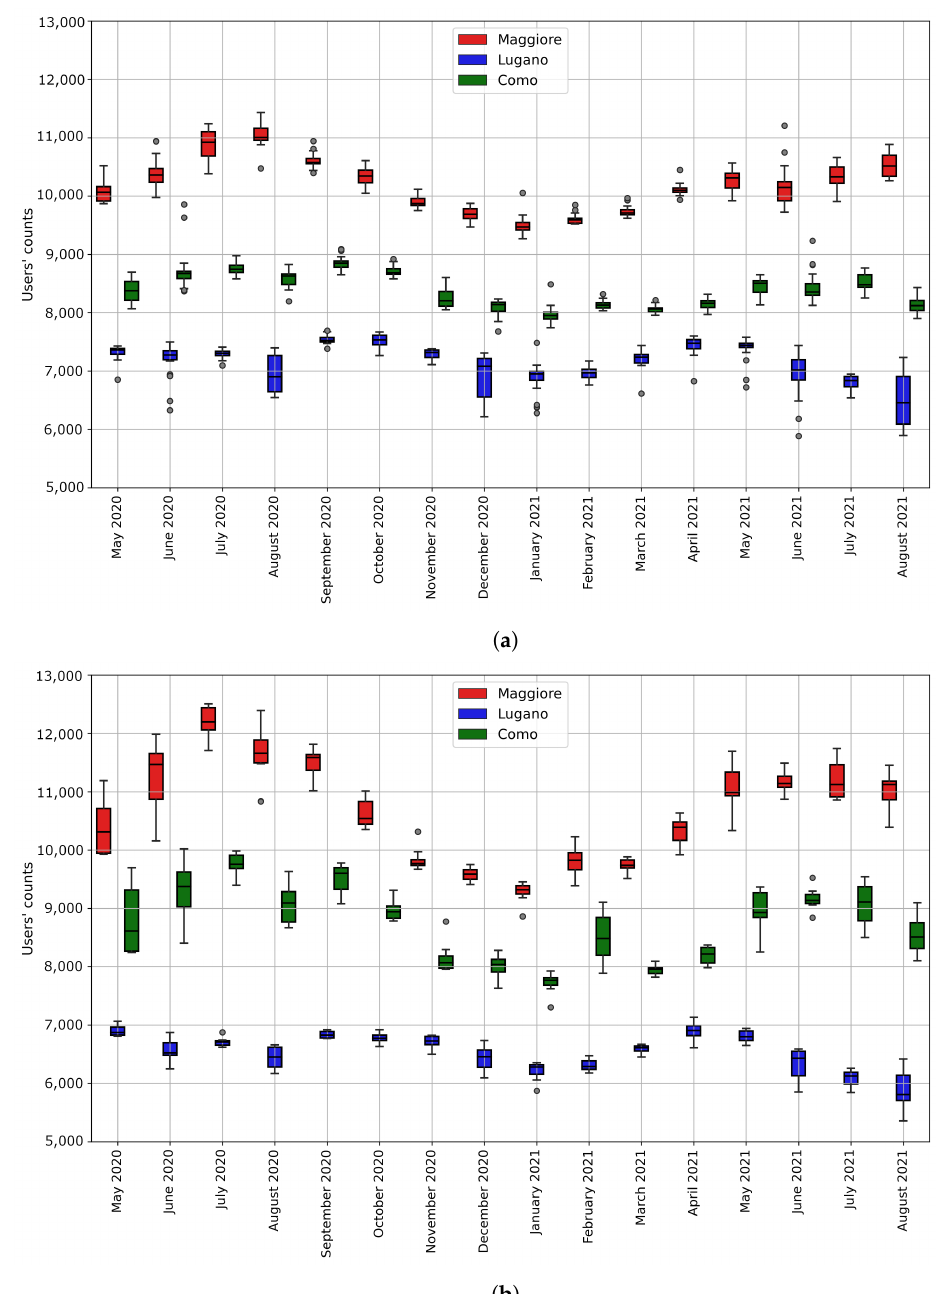
Figure 4. Boxplots of the Facebook users’ count distributions per month by weekdays ( a ) and weekends ( b ) for the three lakes. Each box is delimited by the first (Q1) and third (Q3) quartiles and the horizontal line inside the box is the median. The two lines extending from the box (whiskers) describe the variability outside Q1 and Q3. Outliers are represented by points beyond the